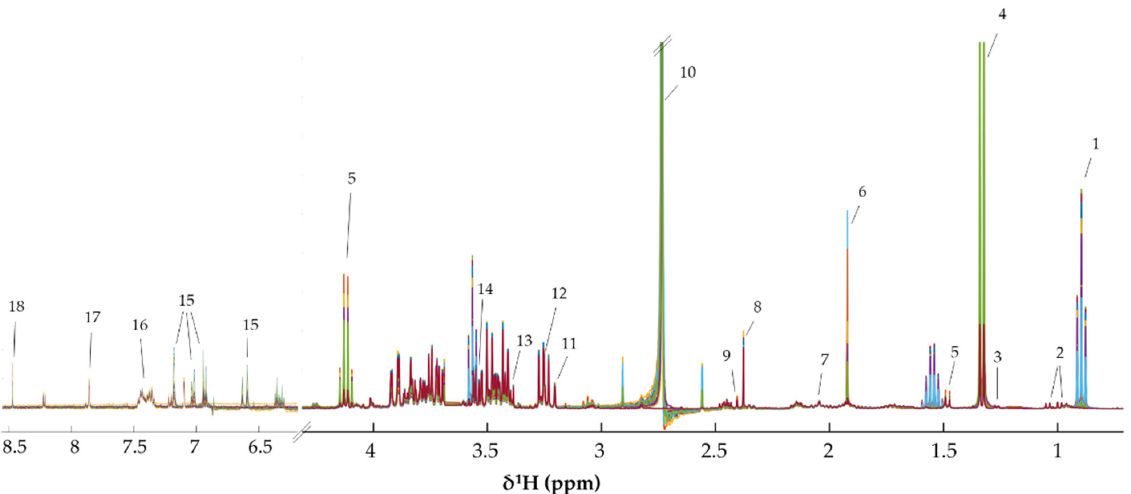
Figure 5. 1 H-NMR spectra of extracellular metabolites of KKU-100 and KKU-213 cells. Key metabolites: (1) L-alpha-aminobutyric acid (2) valine (3) methylmalonate (4) lactate (5) alanine (6) acetate (7) glutamine (8) pyruvate (9) succinate (10) dimethylamine (11) choline (12) arginine (13) glycine (14) glucose (15) coniferyl alcohol (16) phenylalanine (17) hypoxanthine (18) formate.